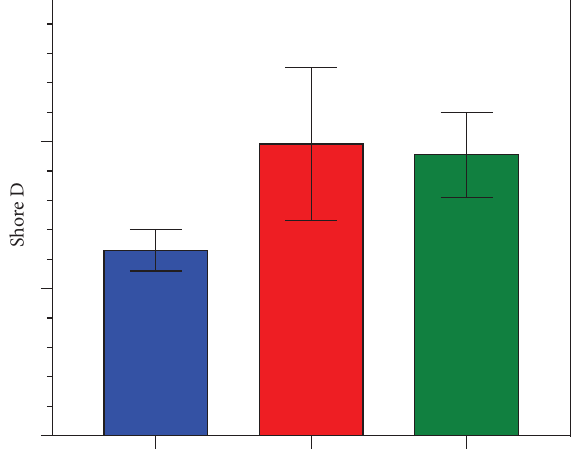
Figure 7: Hardness test outcome.